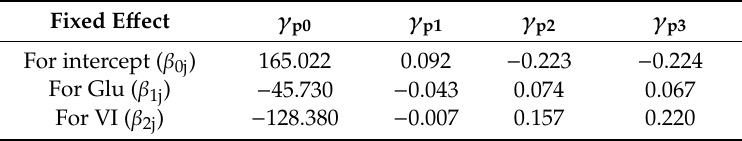
Table 5. Parameters of the hierarchical linear model for predicting